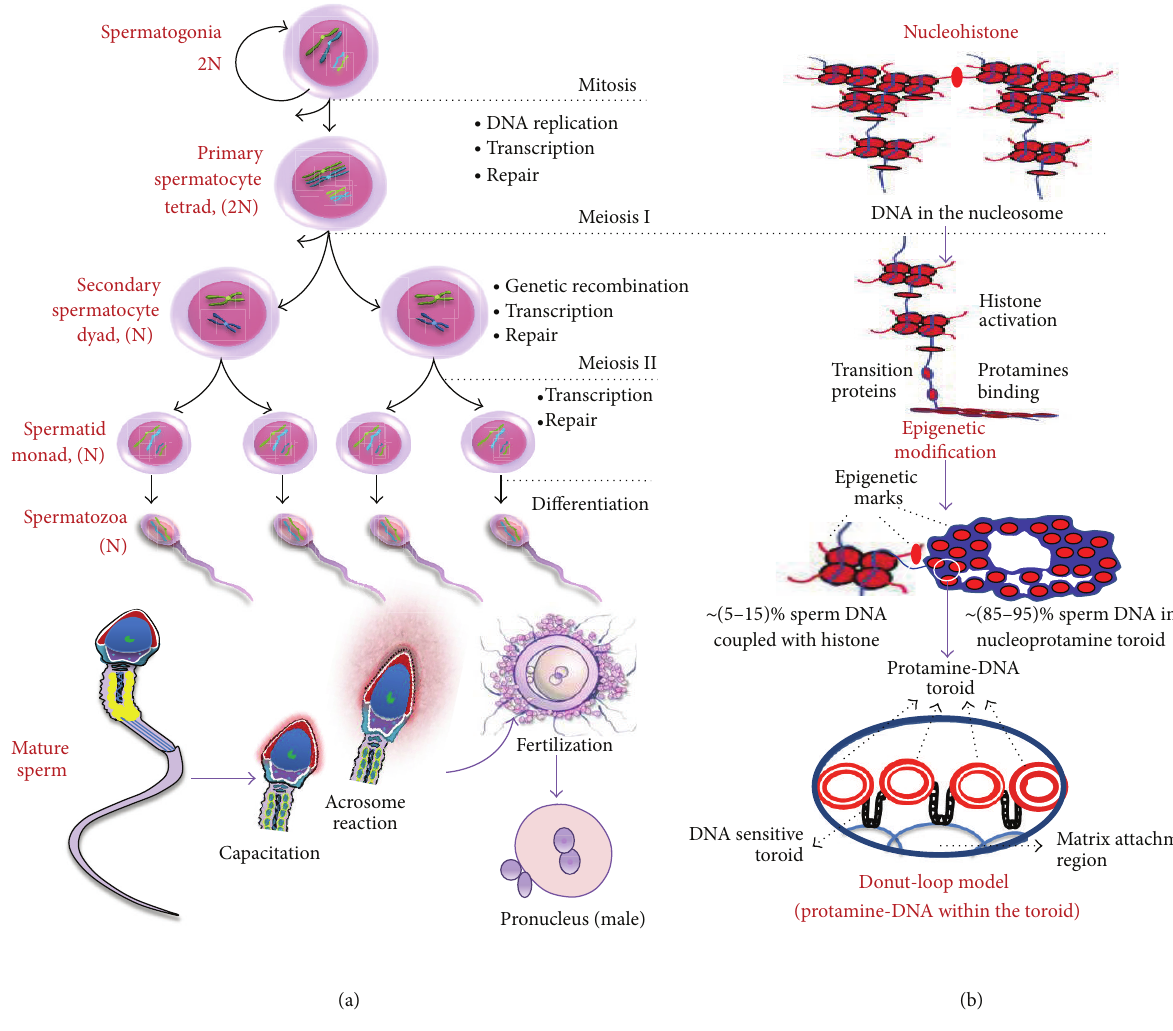
Figure 1: Schematic diagram showing the cellular, genetic, and chromatin changes during spermatogenesis. (a) The figure represents the cellular changes during spermatogenesis coupled with its genetic modifications. Following spermatogenesis, the male primordial germ cells, spermatogonia, first differentiate to primary spermatocytes and undergo genetic recombination to produce haploid round spermatids. The round spermatids then participate in another differentiation process to produce the mature spermatozoa. For successful fertilization, mammalian spermatozoa undergo first capacitation and then the acrosome reaction, which collectively allows spermatozoa to penetrate the zona pellucida and to fuse with the oocyte plasma membrane both in vivo and in vitro . (b) The figure shows chromatin changes that cause the transition of the mammalian nucleohistone to nucleoprotamine [17, 18]. In addition, the Donut-Loop model has been inserted at the end to represent the internal structure of the protamine-DNA fibers inside the toroid [17, 18]. The red color indicates histones and the blue color indicates